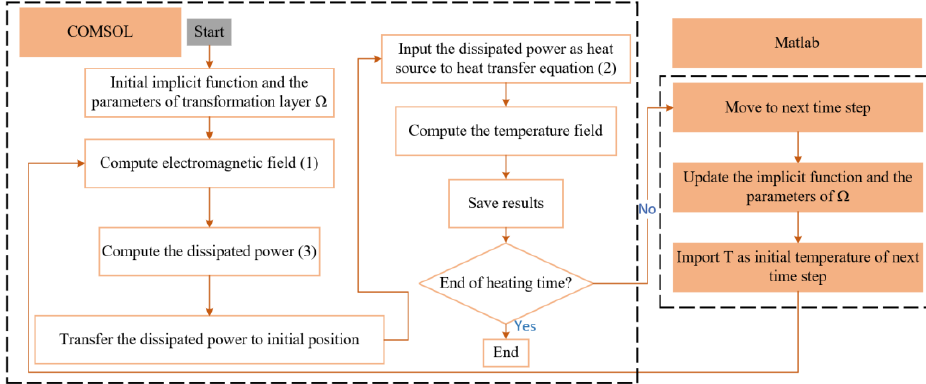
Figure 5. The flowchart of the simulation.